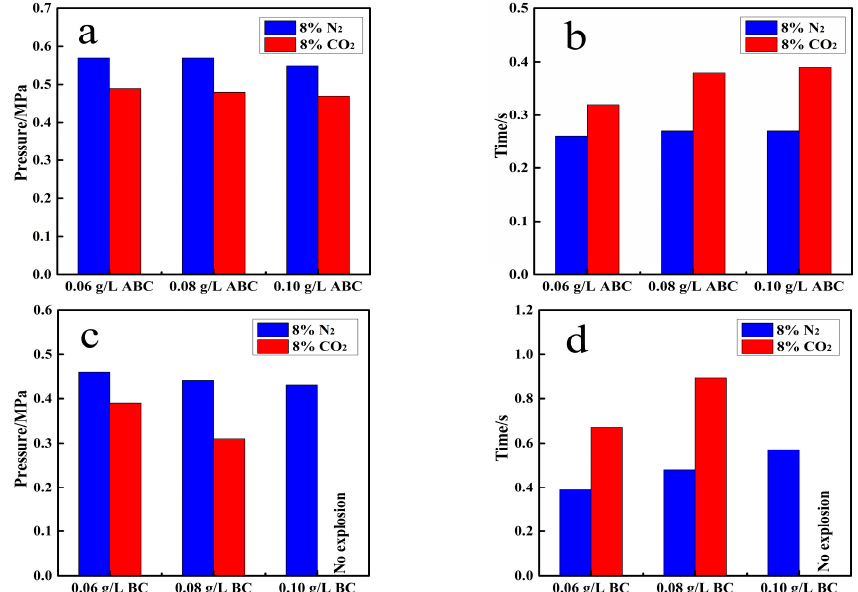
Figure 4. The explosion characteristic parameters of methane inhibited by different inert gases mixed with powders: ( a ) the max-pressure of different inert gases/ABC; ( b ) the time to max-pressure by different inert gases/ABC; ( c ) the max-pressure of different inert gases/BC; ( d ) the time to max-pressure of different inert